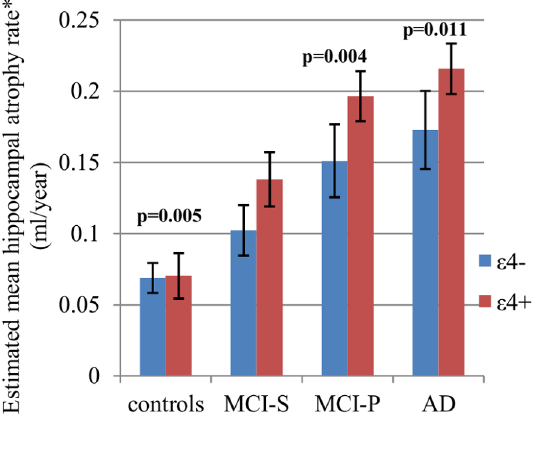
Figure 3. Effect of APOE e 4 on hippocampal atrophy rates.* doi:10.1371/journal.pone.0097608.g003 PLOS ONE |